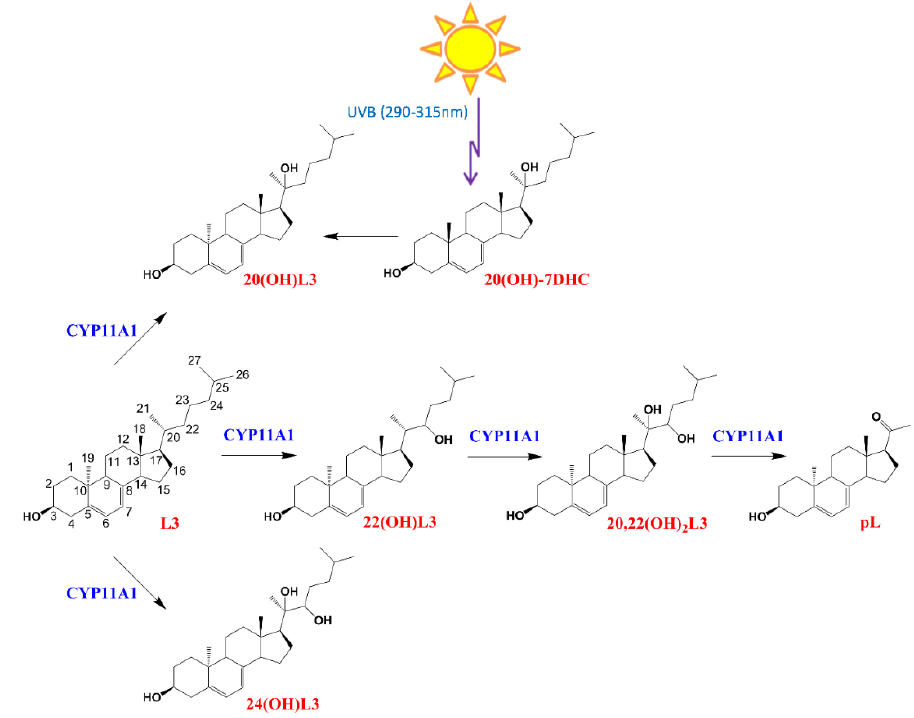
Figure 1. The chemical structures and pathway of synthesis of L3 hydroxyderivatives. pL, pregna-